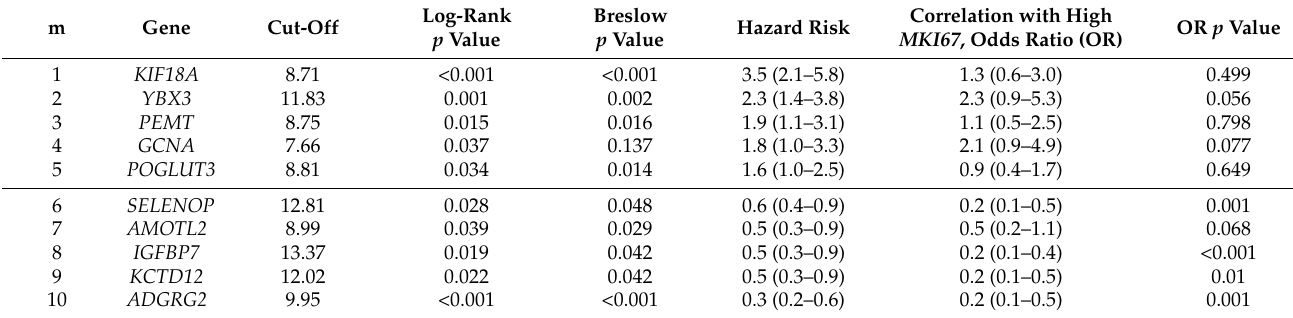
Table 3. Kaplan–Meier analysis for prediction of overall survival outcome (Method